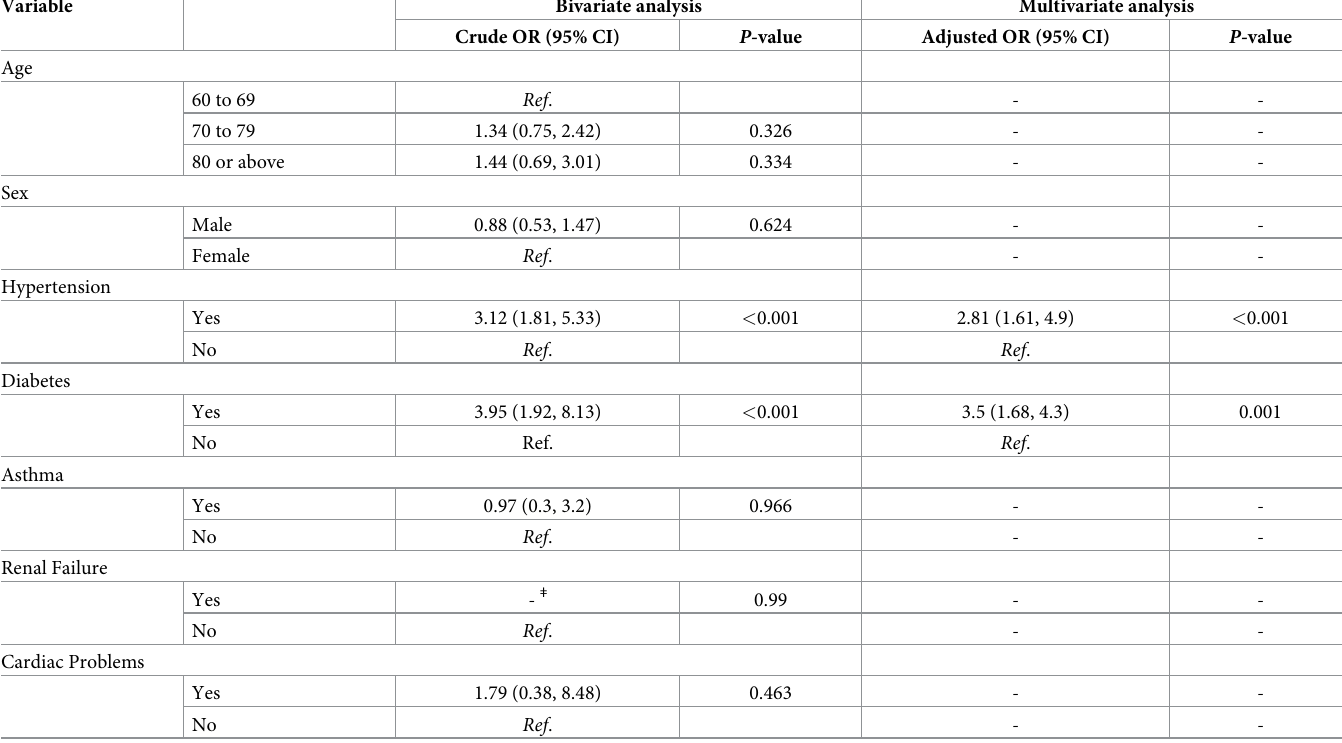
Table 7. Associations of NSAID-related drug interactions with age, gender and clinical